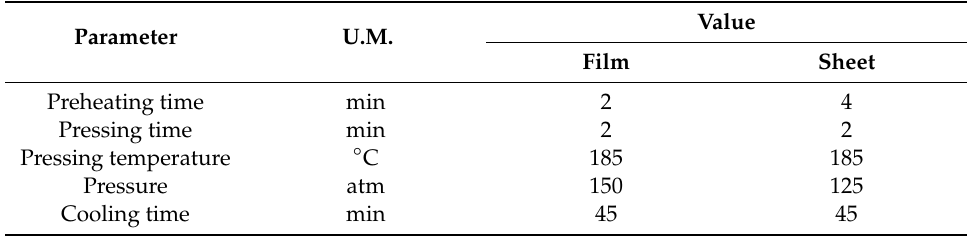
Table 2. Processing parameters for obtaining of post-consumer rPP / SBS, rPP / SIS, rPP / SBS / GB, and rPP / SIS / GB sheets and